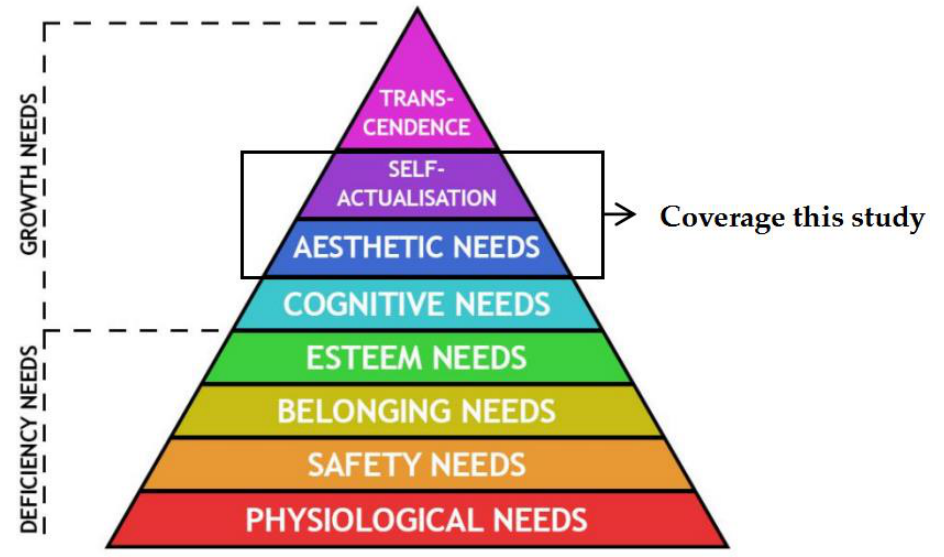
Figure 1. Maslow’s hierarchy of needs model.